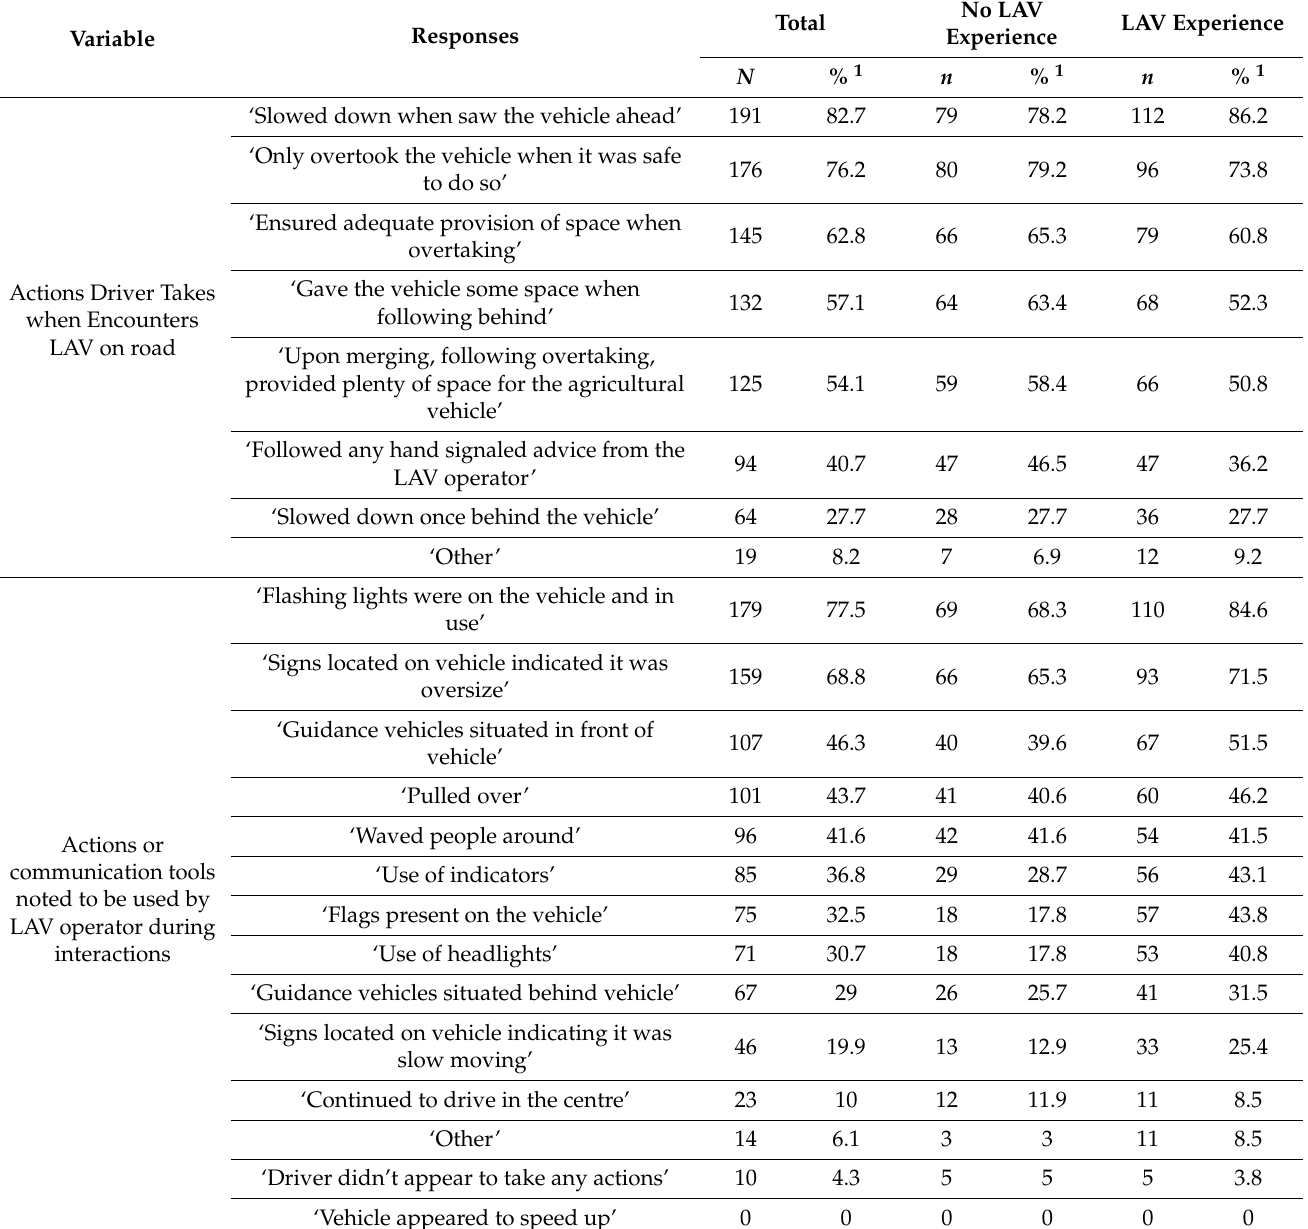
Table 3. Large agricultural vehicles on roads: Recall of most recent interaction experience/s.